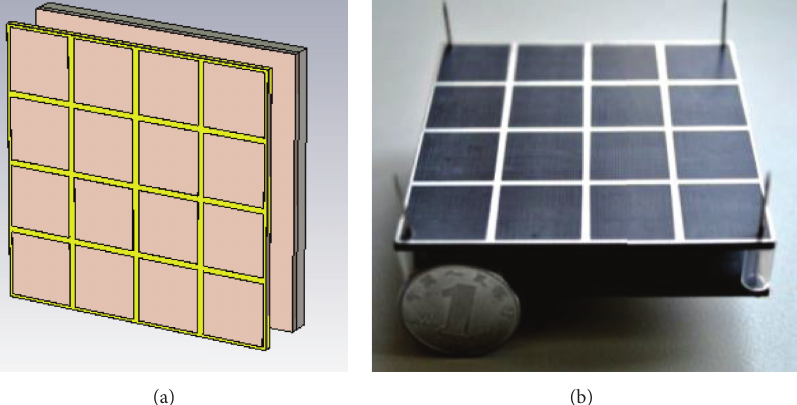
Figure 4: The prototype of the proposed wideband antenna with the ZIM cover, (a) the setup for the numerical simulations and (b) the proposed antenna